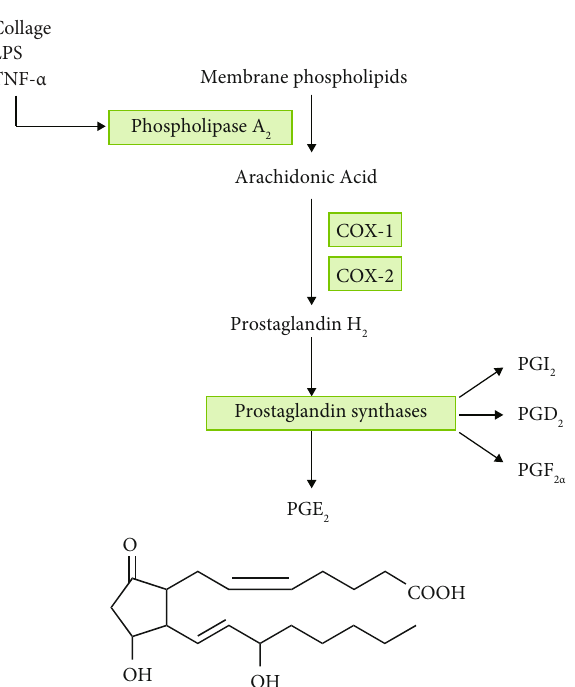
Figure 1: The process of PGE synthesis. Arachidonic acid is released 2 . Cyclooxygenases (COX-1 from the membrane by phospholipase A 2 and COX-2) produce prostaglandin H (PGH ) from arachidonic 2 2 acid. PGH is produced by prostaglandin synthase to produce PGI 2 PGD , PGE , and PGF 2 2 2 α